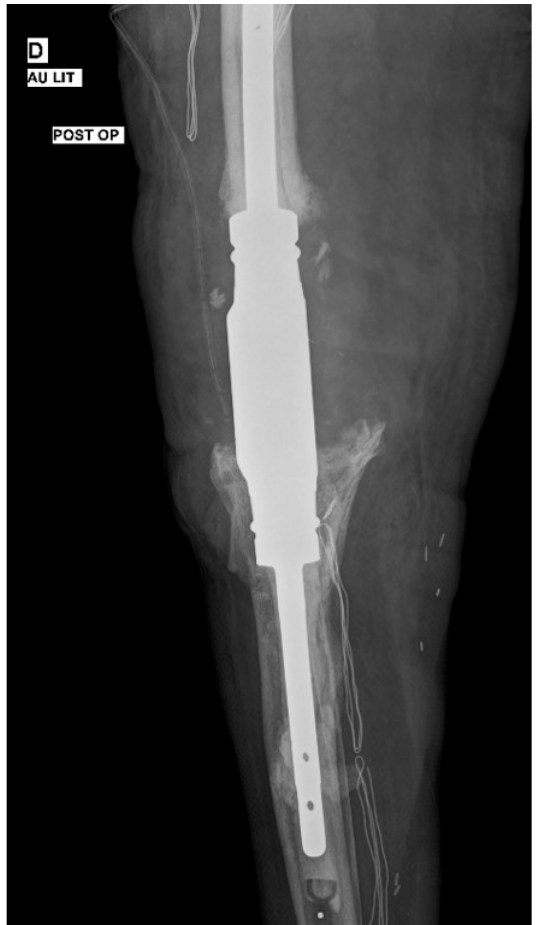
Figure 4. Anteroposterior post-operative radiographic view of a prosthesis-arthrodesis implant. Four months after the last operation, she was free from pain and had no signs of PJI.